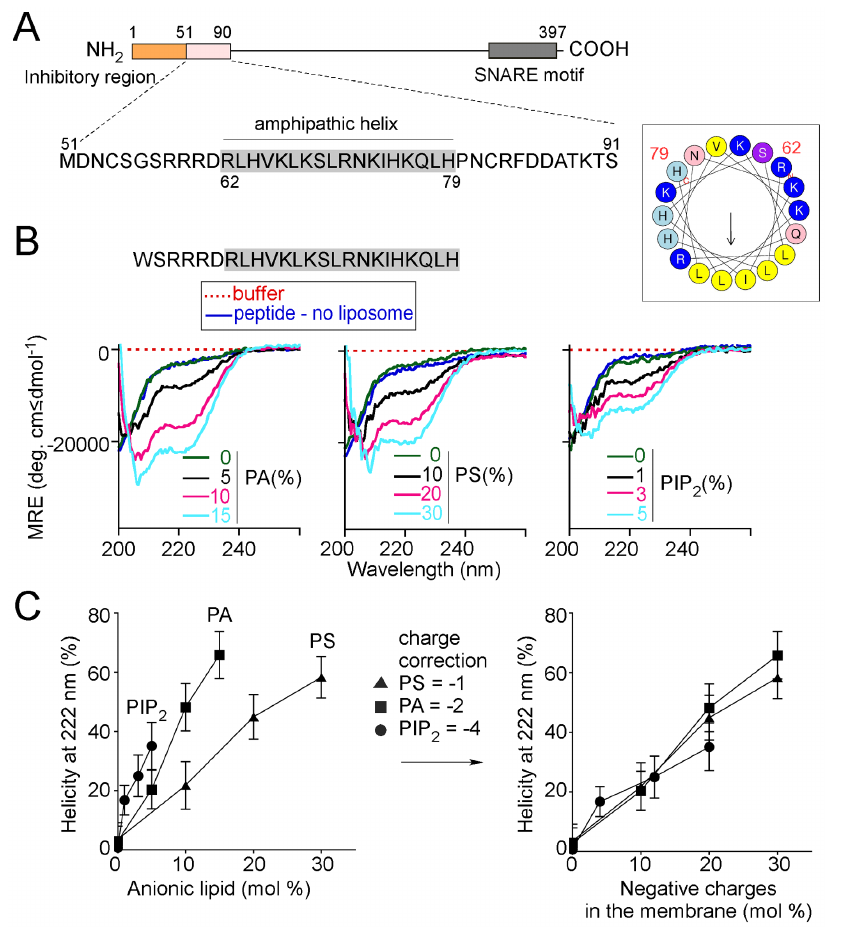
Figure 1. Folding of the membrane sensor region of Spo20 onto anionic liposomes. ( A ) Domain organization of Spo20. The sequence of the membrane-binding region is indicated. The helical wheel representation, which was drawn using heliquest (http://heliquest.ipmc.cnrs.fr/) [28], illustrates the amphipathic character of its central part. Hydrophobic residues are shown in yellow, arginines and lysines in dark blue, histidines in light blue, glutamine and asparagine in pink and serine in purple. ( B ) Far-UV CD spectra of the Spo20 peptide (aa 56–79; 30 m M) in solution (dark blue curve) or with 3 mM of small liposomes (Rh 5 15 ¡ 4 nm) containing increasing % of either PA, PS, or PIP 2 (black to cyan curves). The remaining lipids in the liposome were (in mol %) PE (25), and PC (the concentration of which varied from 75 to 45% depending on the concentration of anionic lipid). MRE, mean residue ellipticity. ( C ) Left: helicity at 222 nm as a function of the percentage of PA, PS or PIP 2 in the liposomes and as determined from the spectra shown in panel B. Right: helicity at 222 nm as a function of the amount of negative charges carried by PA, PS or PIP 2 in the liposomes.